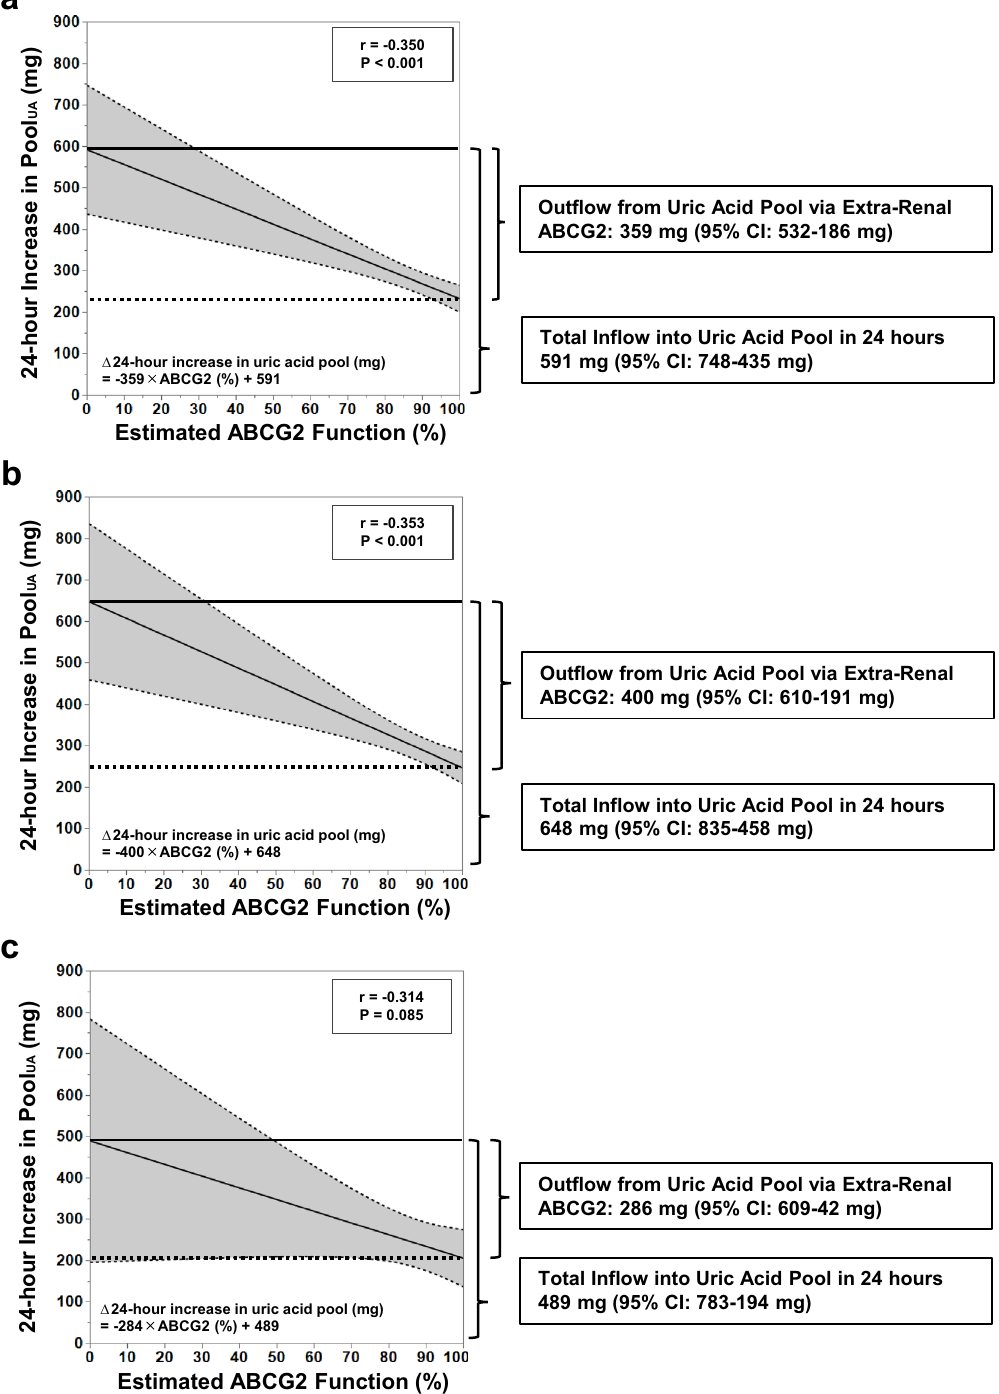
Figure 4. Contribution of extra-renal ABCG2 to urate excretion. The solid line shows the estimated regression for increase in uric acid pool per 24 h, and dotted lines show the 95% confidence interval of the regression line. ( a ) The regression model was derived from all hemodialysis participants (n = 123). The outflow/inflow of uric acid from/into the uric acid pool is 60.7%, and the ratio indicates the contribution of ABCG2 in urate excretion. ( b ) The regression model was derived from male hemodialysis participants (n = 92). The outflow/inflow ratio is 62.9%. ( c ) The regression model was derived from female hemodialysis participants (n = 31). The outflow/inflow ratio is